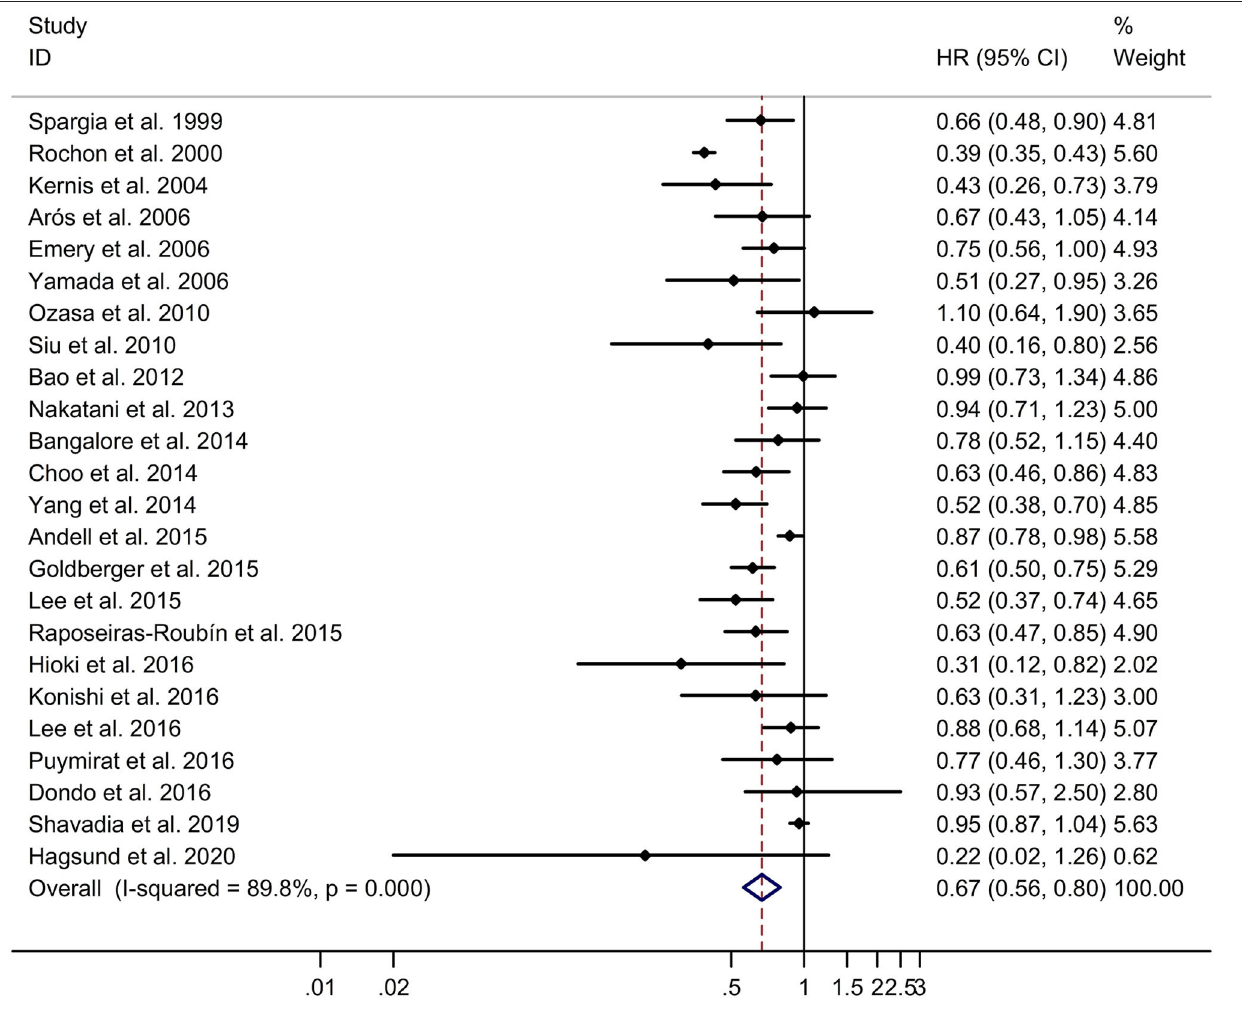
Frontiers in Cardiovascular Medicine |